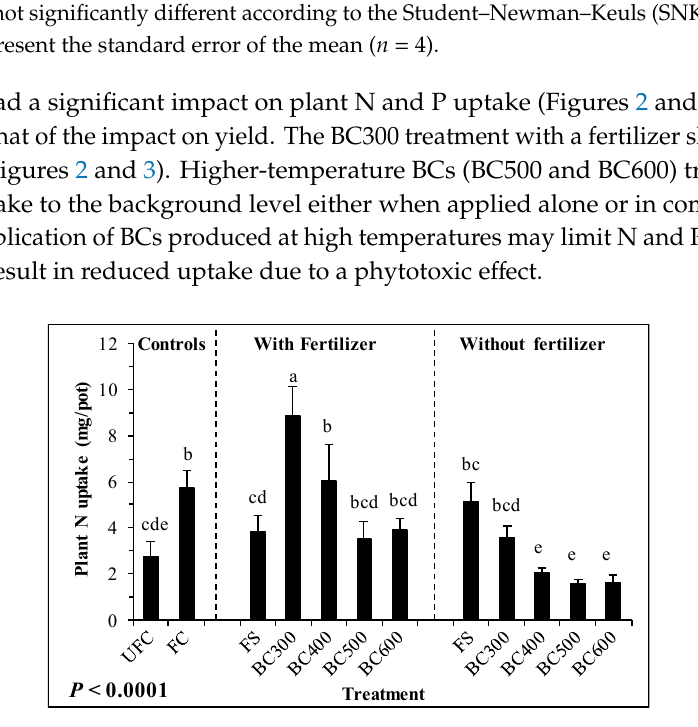
Figure 2. Plant N uptake in soil receiving 8 t ha − 1 of four date palm residue BCs produced with different pyrolysis temperatures (BC300, BC400, BC500, and BC600) and the BC FS with and without a fertilizer added. Treatments also included a UFC and an FC. Bars sharing the same letter among treatments are not significantly different according to the SNK test ( p ≤ 0.05). Errors bars represent the standard error of the mean ( n =4).